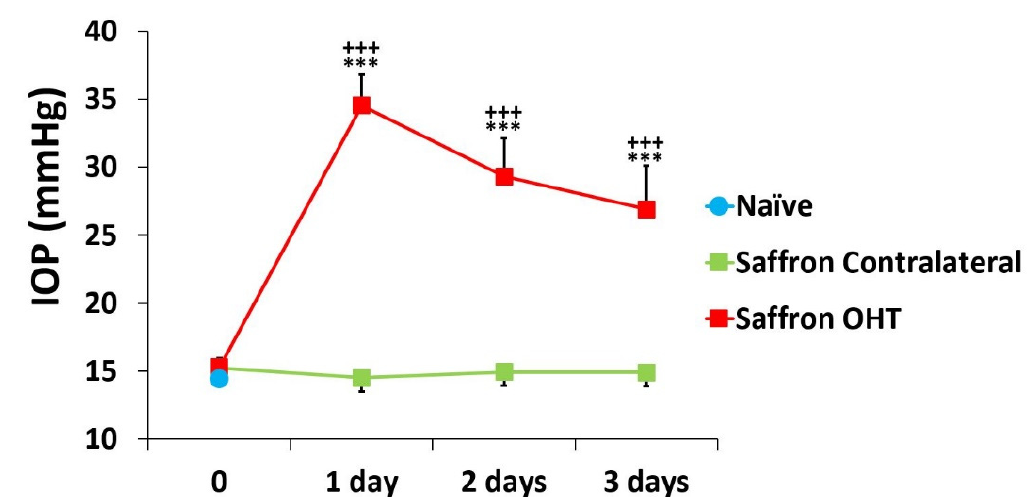
Figure 1. Intraocular pressure (IOP) values after laser-induced ocular hypertension (OHT) in 1, 2, and 3 days after laser OHT induction in saffron-naïve eyes, saffron ocular hypertension eyes (Saffron OHT), and saffron-contralateral eyes (saffron-contralateral). Statistical significance indicators: *** p < 0.001 vs. saffron-naïve; +++ p < 0.001 vs. saffron-contralateral.